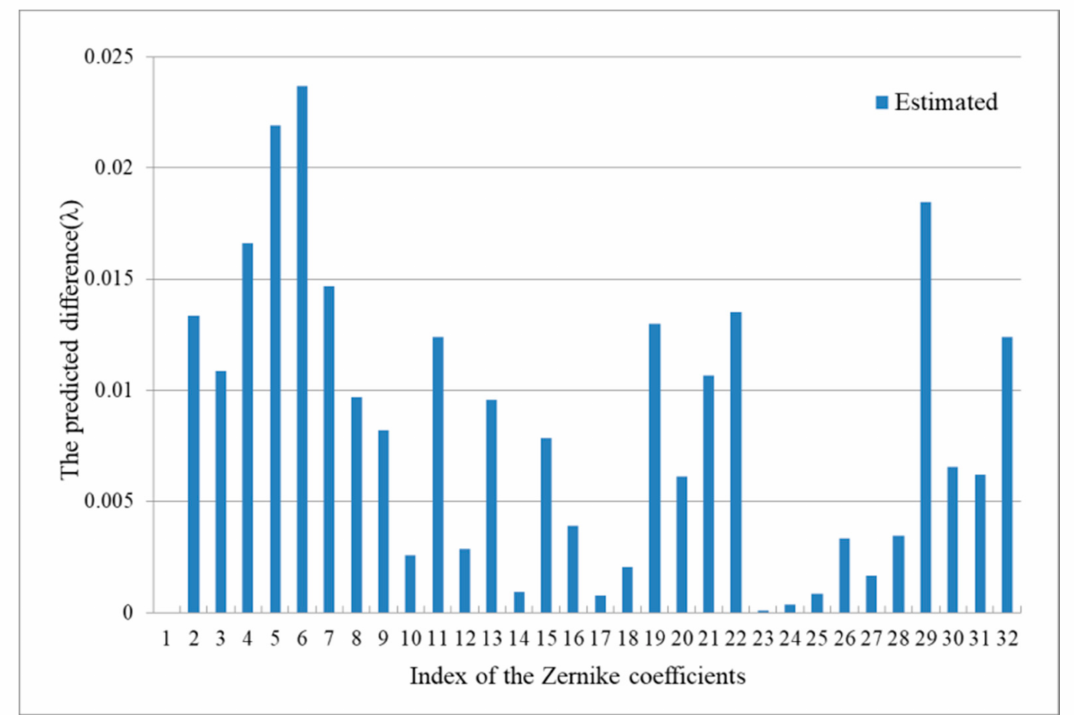
Figure 8. The Zernike coefficients and the predicted